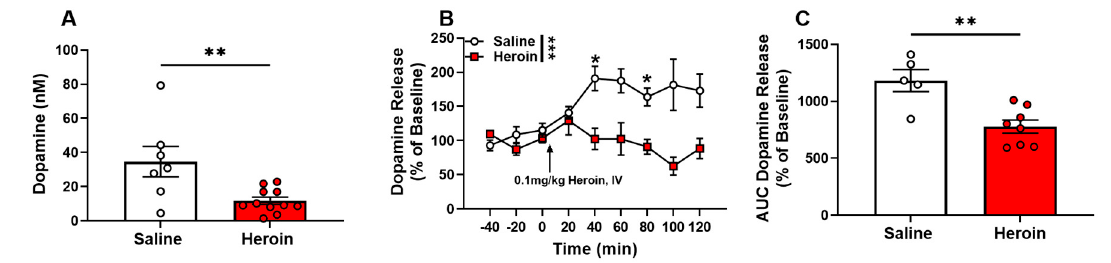
Figure 6. Heroin self-administration decreased basal extracellular levels of dopamine in the NAc and dopamine response to a heroin challenge. ( A ) Overnight (basal) extracellular dopamine was significantly lower in heroin-exposed rats. ( B ) Following the heroin challenge (0.1 mg/kg, IV), heroin-exposed rats showed no significant increase in extracellular dopamine, while significant, prolonged increases were observed in saline rats. ( C ) Heroin-exposed rats showed significantly decreased dopamine when compared to saline control rats. * p < 0.05; ** p < 0.01; *** p < 0.001.